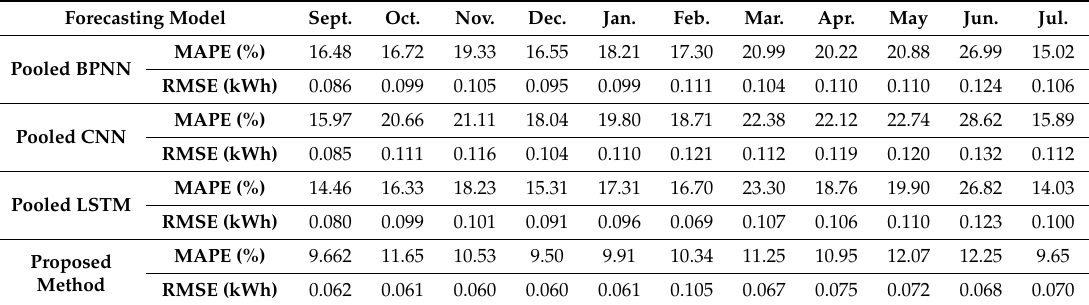
Table 5. Monthly-average of MAPE for the lower uncertain household.